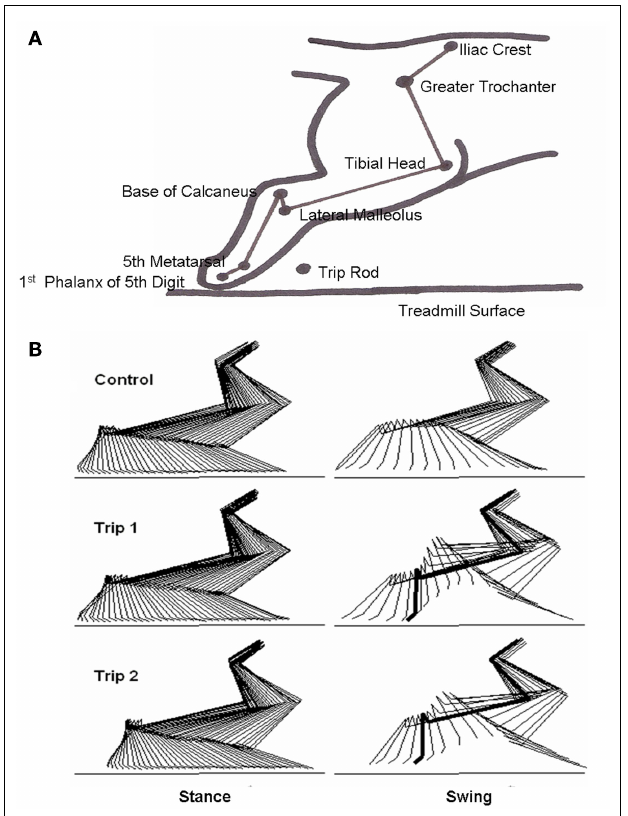
FIGURE 1 | (A) Schematic showing the bony landmarks in the cat hindlimb used for kinematics analyses, the position of the trip rod, and the treadmill surface. (B) Representative stick diagrams (17ms between sticks) showing the stance and swing phases for a pre-trip (Control) step and the first (Trip 1) and second (Trip 2) trip steps.The horizontal lines denote the surface of the treadmill.The thick lines in the stick diagrams duringTrip 1 andTrip 2 indicate the frame when the foot touches the trip rod during the swing